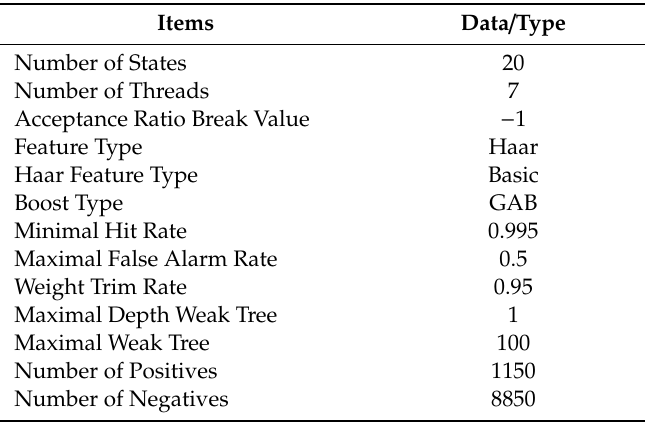
Figure 4. Positive and negative image examples. Table 1. Haar-cascade training technical data.